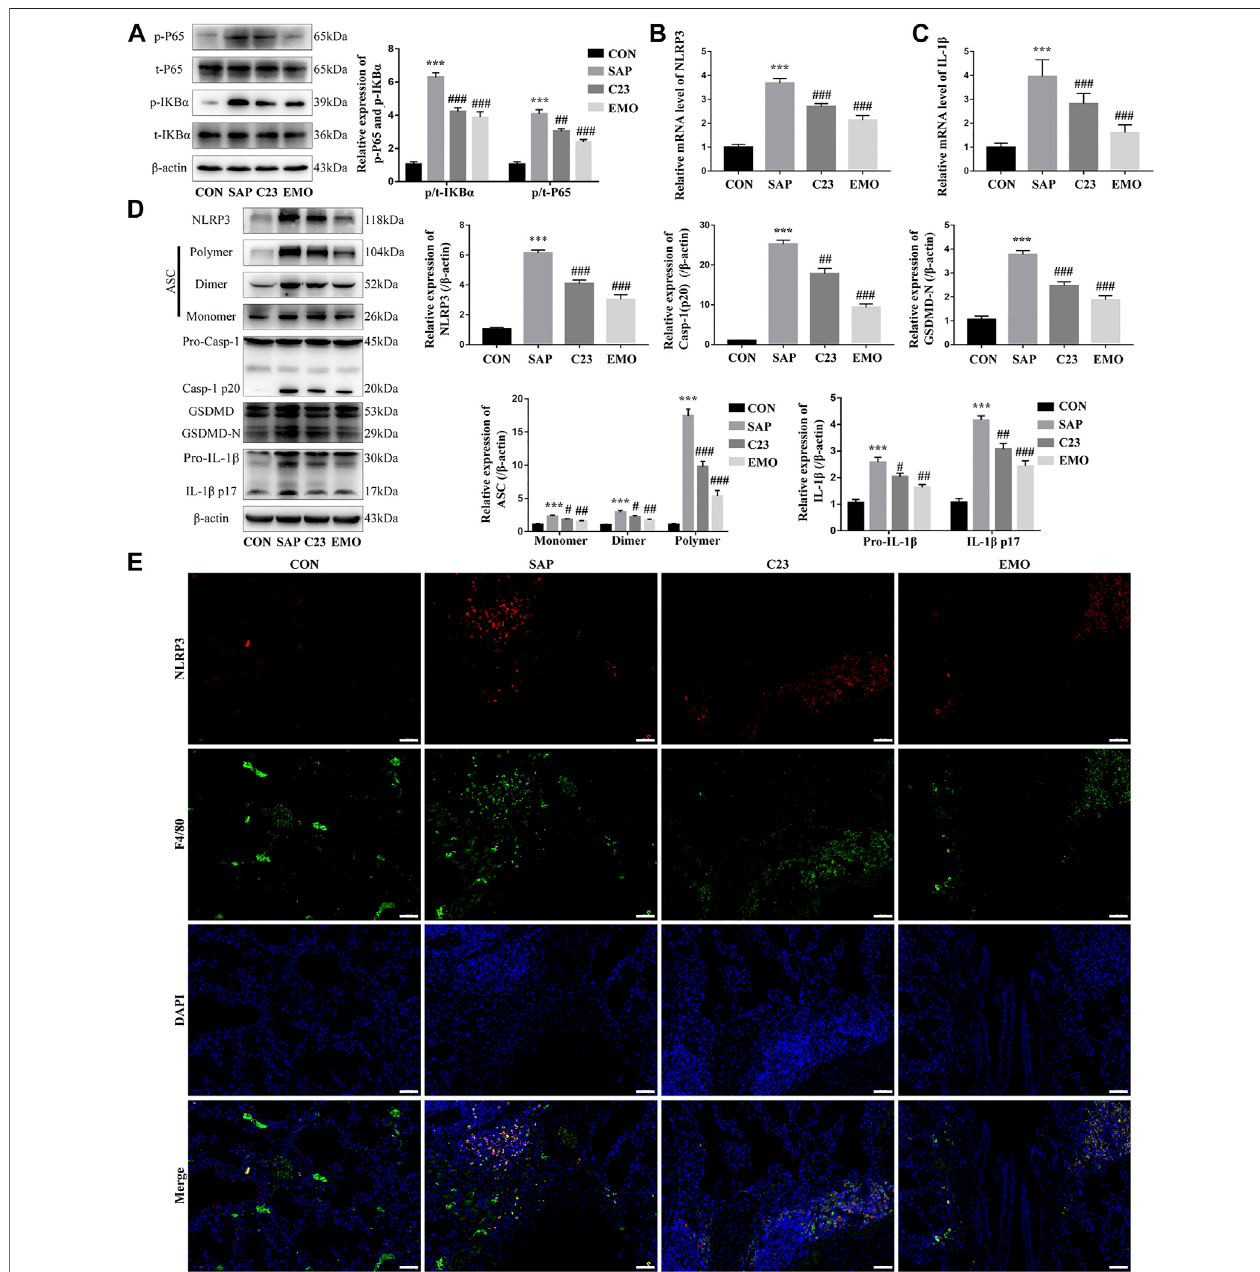
FIGURE 3 | Treatment with emodin, like C23, signi fi cantly attenuates the SAP-activated NF- κ B signaling and NLRP3 in fl ammasome formation in the lungs of rats. (A) Western blot analysis of the relative levels of NF- κ Bp65 and IKB α tothe control β -actin expression and phosphorylation in the lung tissues ofrats. (B, C) Quantitative analysis of the relative levels of NLRP3 and IL-1 β to the control GAPDH mRNA transcripts in the lung tissues of rats. (D) Western blot analysis of the relative levels of NLRP3, ASC (Monomer, Dimer, Polymer), caspase1 (Pro-Casp-1, Casp-1 p20), GSDMD (GSDMD, GSDMD-N), and IL-1 β (Pro-IL-1 β , IL-1 β p17) to the control β -actinexpressioninthelungtissuesofrats. (E) Immuno fl uorescentanalysisoftheNLRP3expressioninthelungresidentmacrophagesusinganti-NLRP3(red)andanti- F4/80 (green). The data are representative images (200 × magni fi cation) or present as mean ± SD of each group of rats ( n (cid:1) 10 per group) from at least three separate experiments; *** p < 0.001 vs. the CON. # p < 0.05, ## p < 0.01, ### p < 0.001 vs. the SAP. Scale bar (cid:1) 50 μ m.